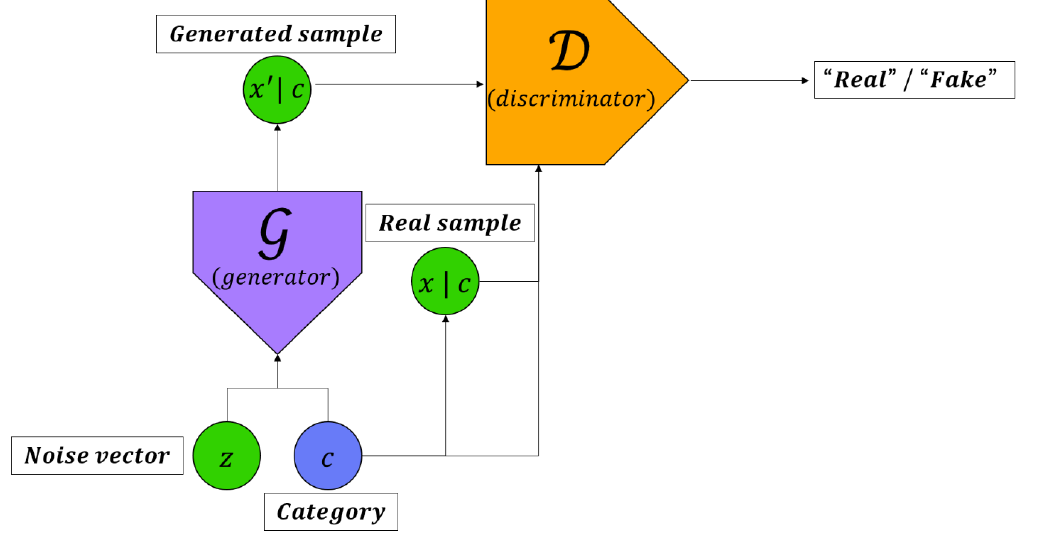
Figure 2. Conditional adversarial network.